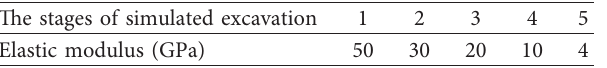
Table 3: The settings of the elastic modulus to simulate the ex- cavation